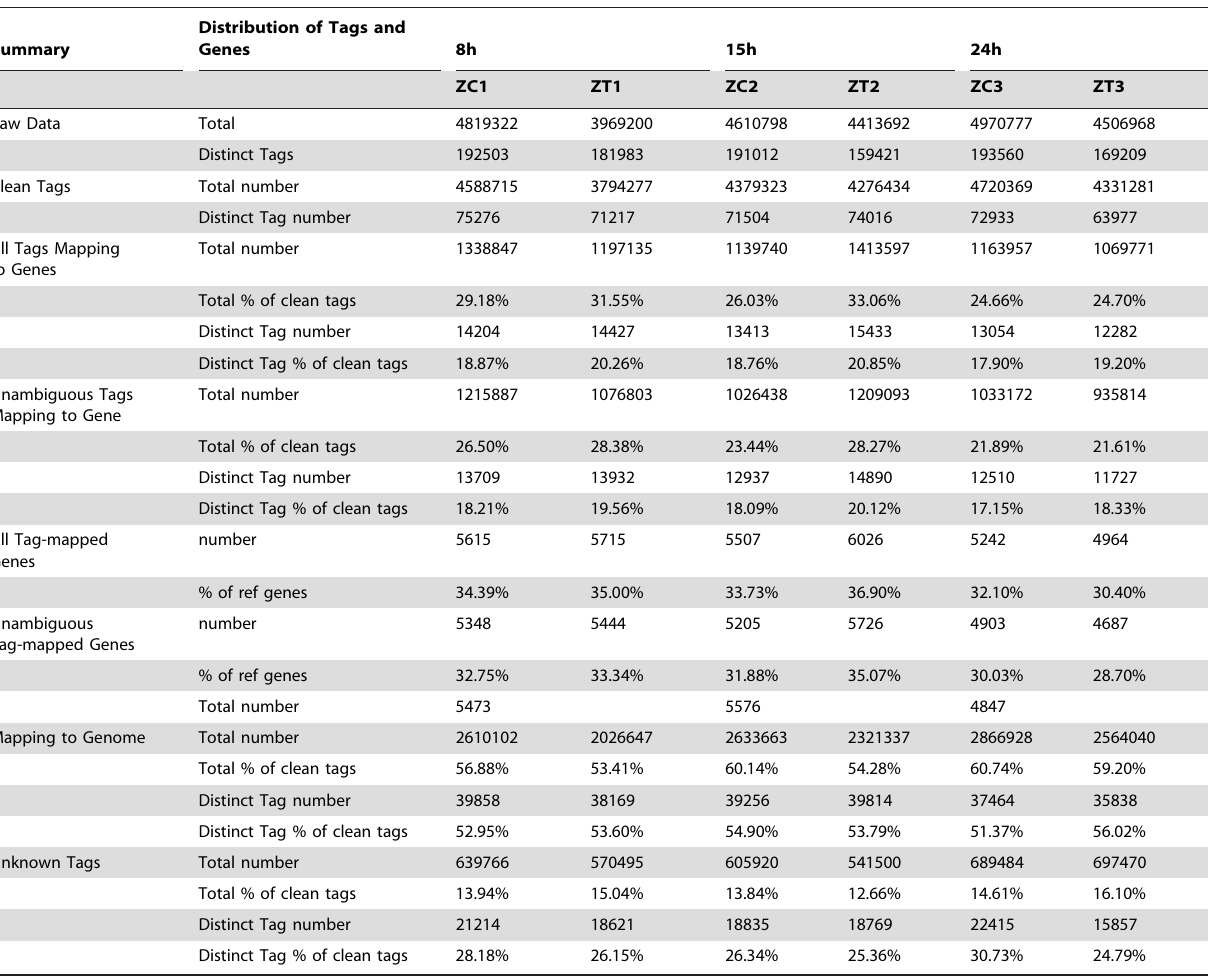
Table 1. Distribution of tags and genes in the DGE libraries.